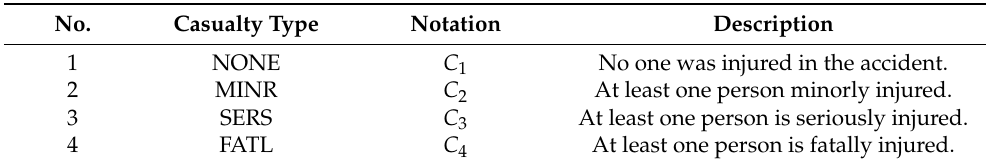
Table 1. Casualty types of civil aviation accidents.